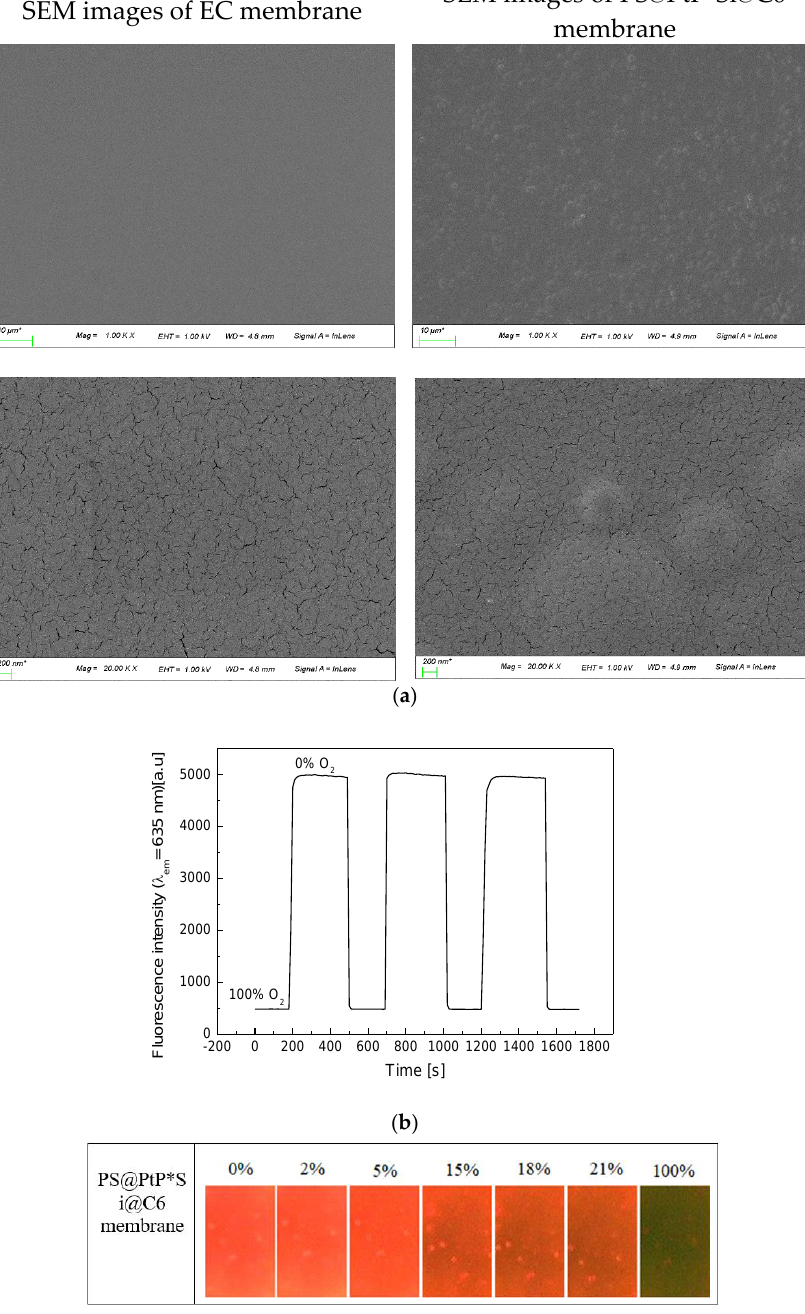
Figure 2. ( a ) SEM images of the EC membrane (left photos) and the PS@PtP*Si@C6 membranes (right photos) at different magnifications; ( b ) repeatability of the PS@PtP*Si@C6 membrane when exposed to concentrations of 100% and 0% oxygen gas; ( c ) photo images of the PS@PtP*Si@C6 membrane when exposed to different concentrations of oxygen gas.